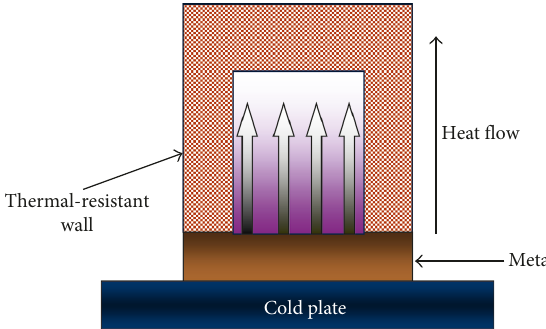
Figure 1: Schematic diagram of the directional freeze-casting